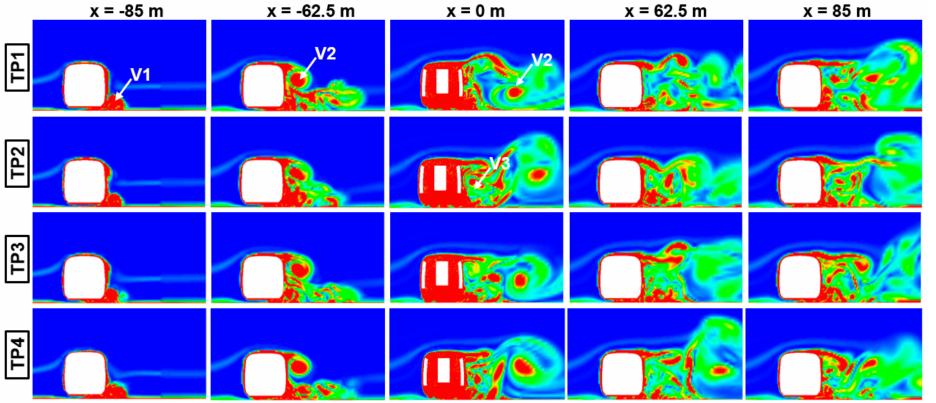
Figure 24. Vorticity contours at different sections at t = 2 s.